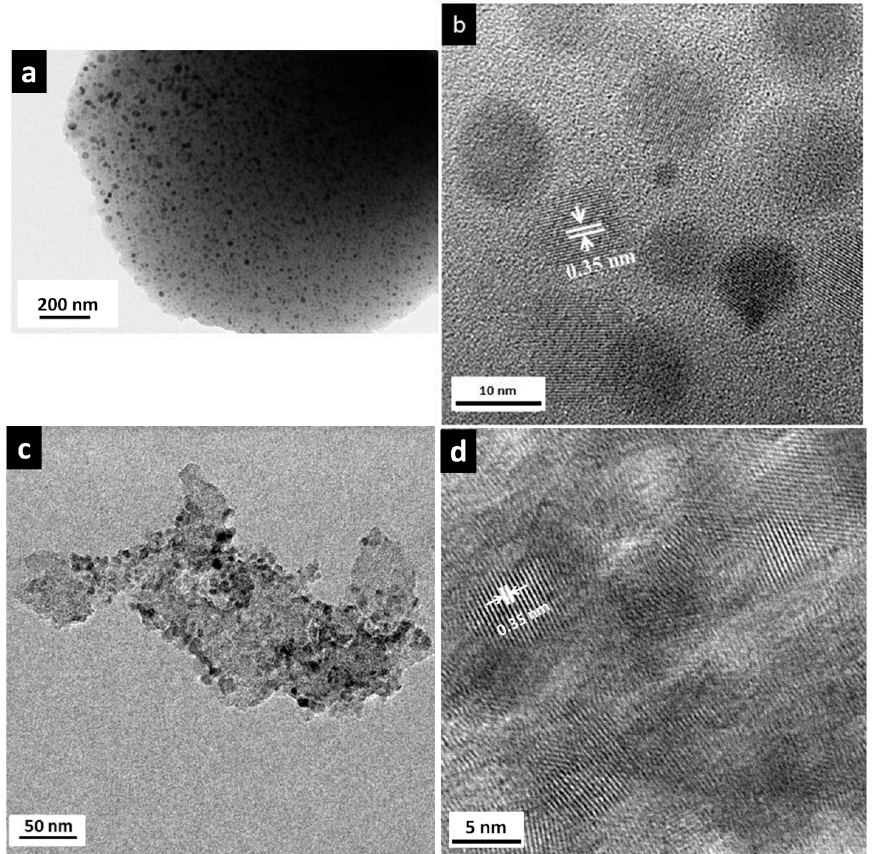
Figure 6. ( a , c ) TEM micrographs of macroporous and mesoporous nanocomposites revealing